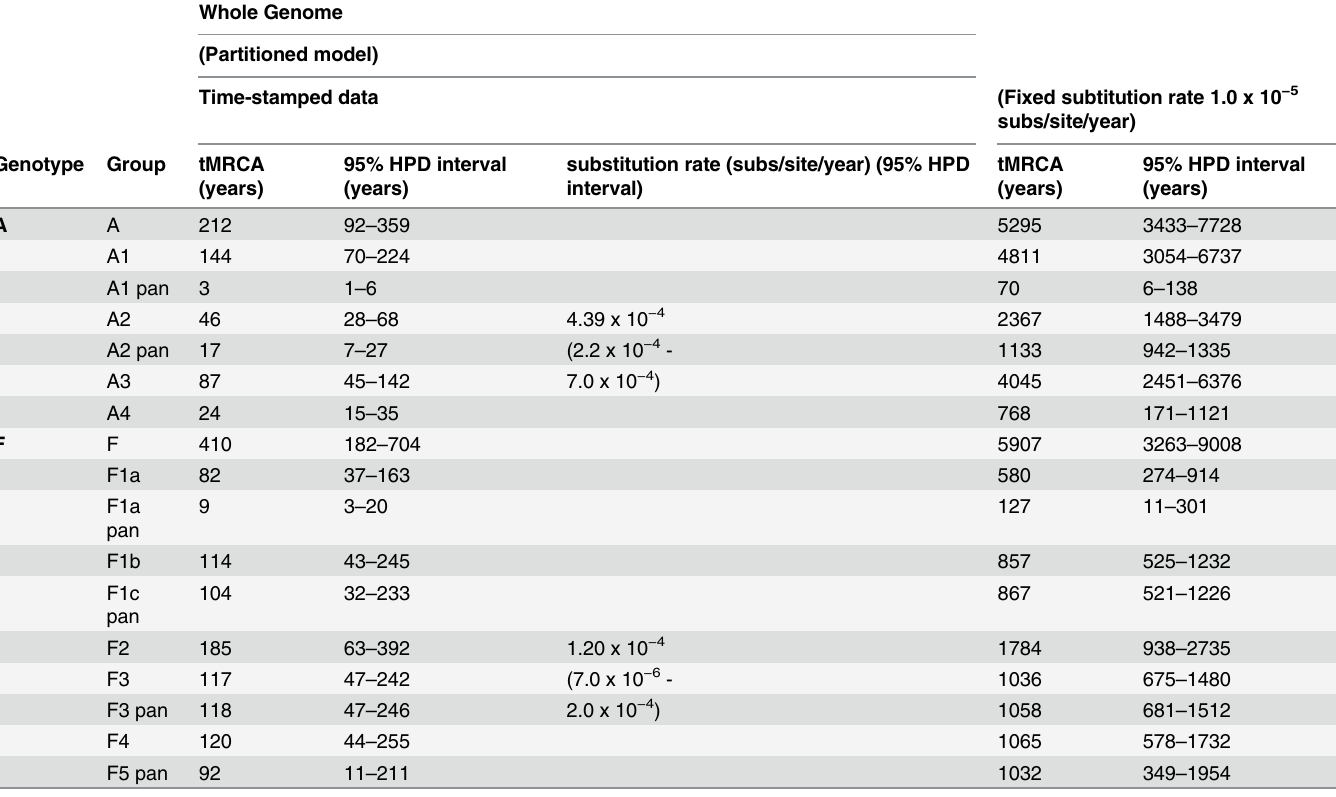
Table 3. Estimated of tMRCA and substitution rate for Genotype A and F, with the HBV Whole genome of the Panamanian samples. Whole